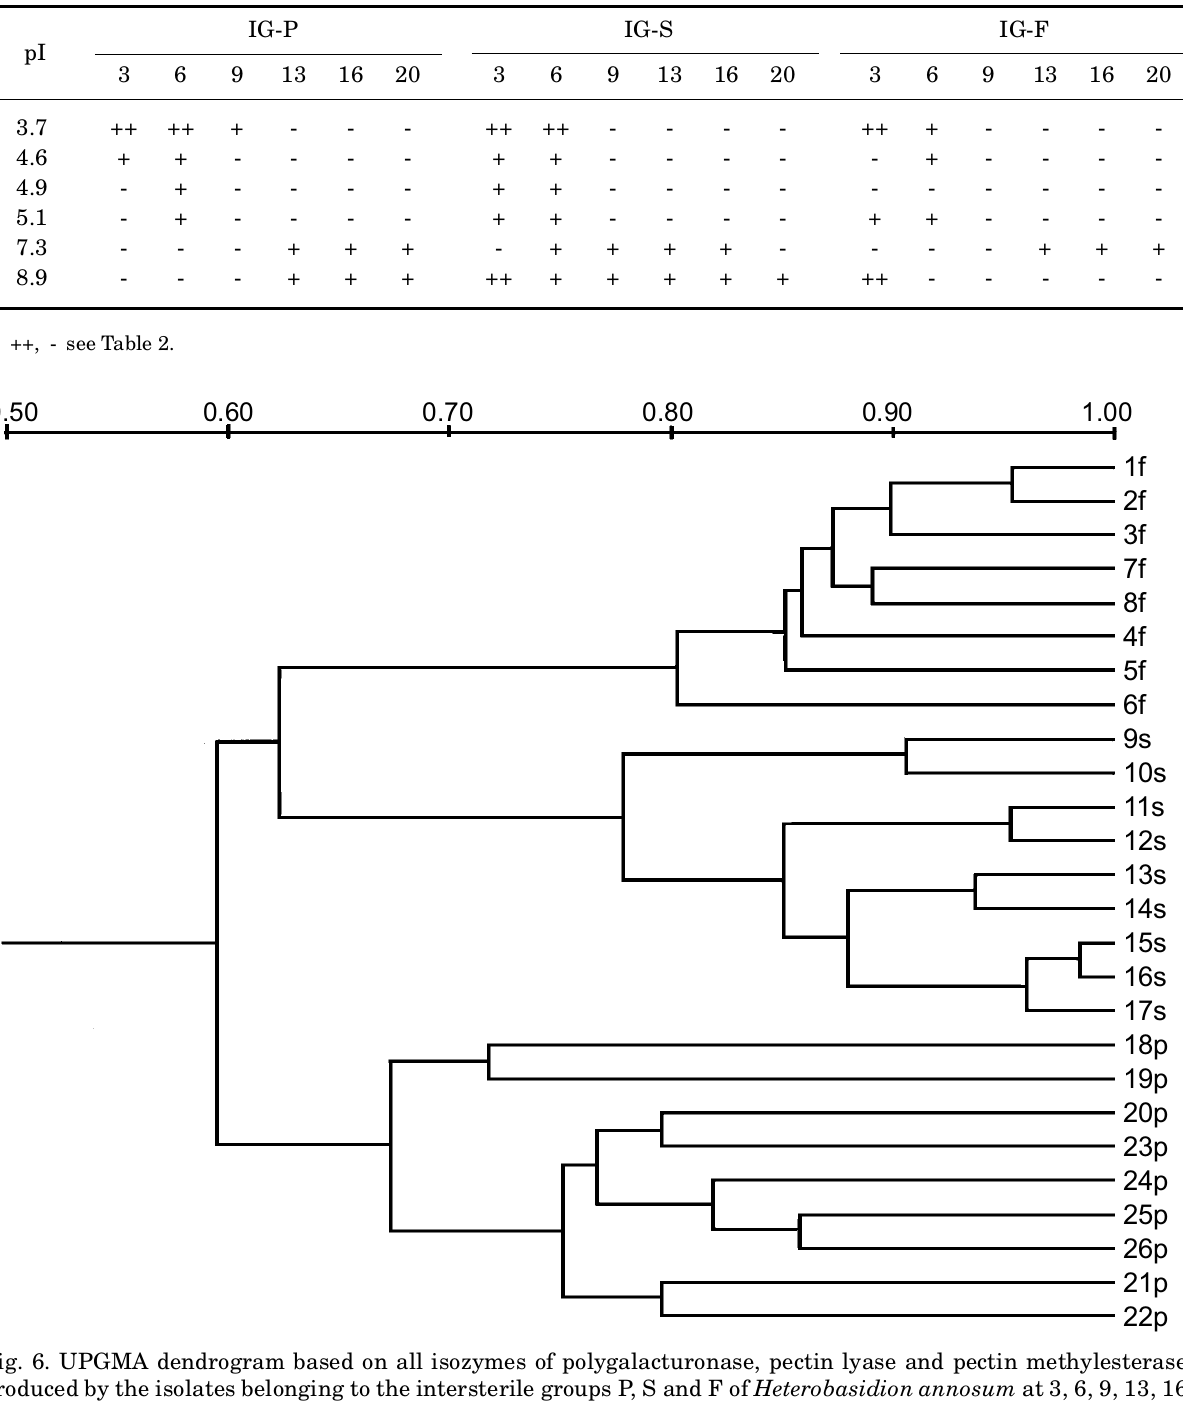
Table 4. Extracellular pectin methylesterase isozymes produced by the intersterile groups (IGs) P, S and F of Hetero- basidion annosum at various days from inoculation in a liquid growth medium with pectin as the sole carbon source.